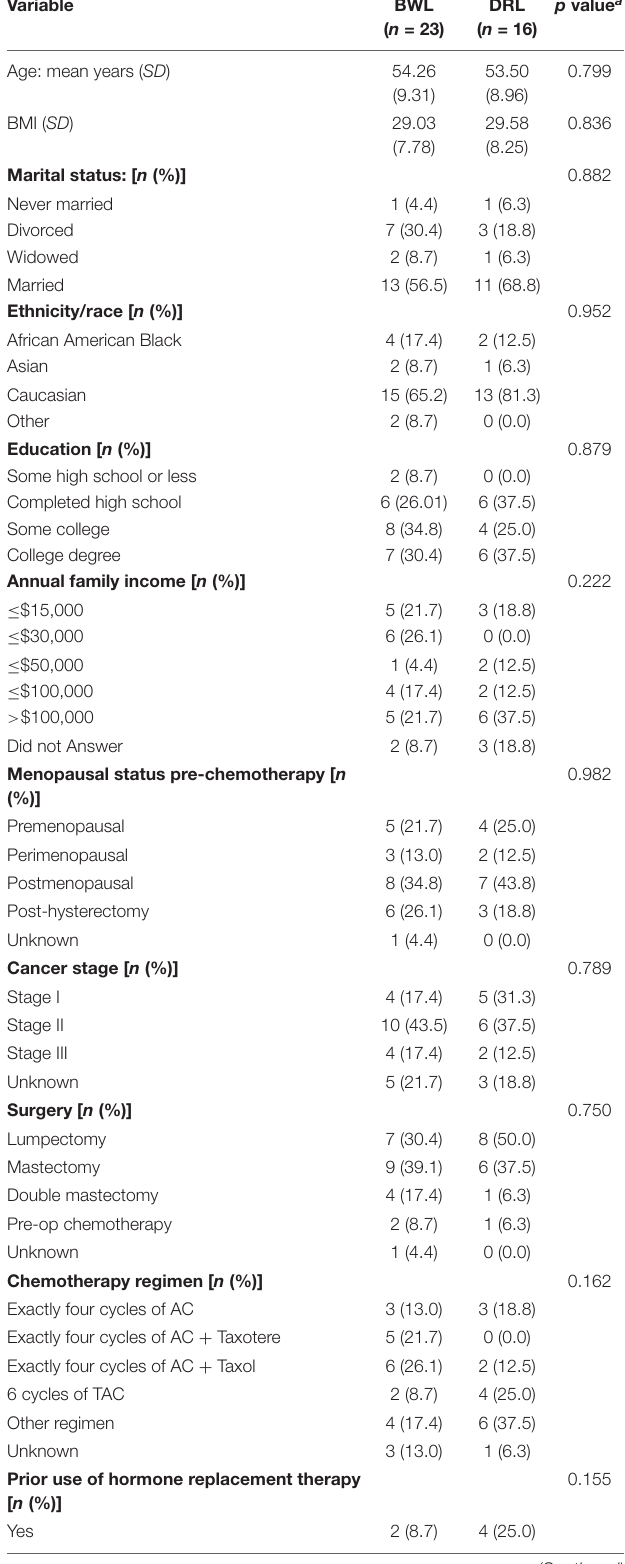
TABLE 1 | Demographic and medical characteristics at baseline ( N =